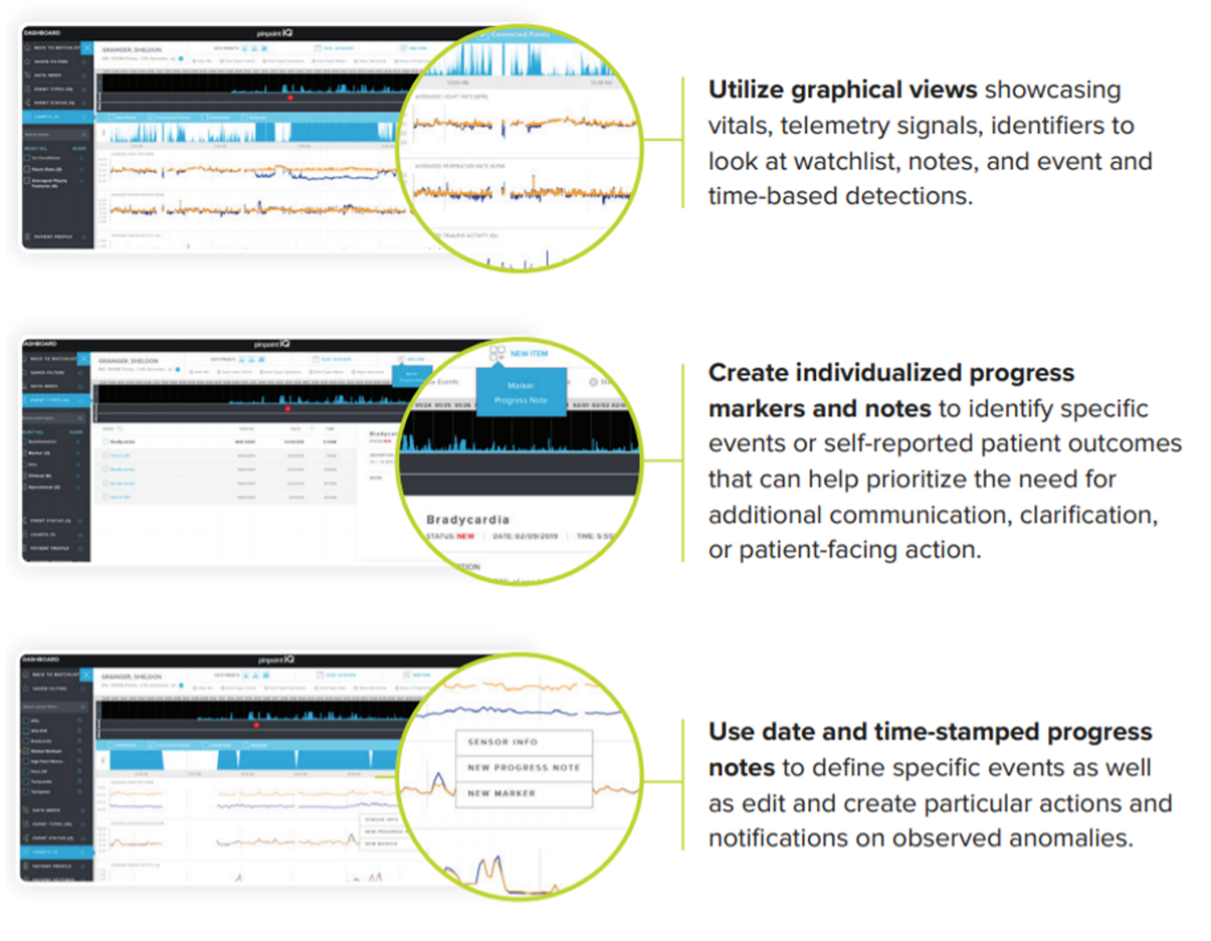
Figure 5. Clinical user's patient